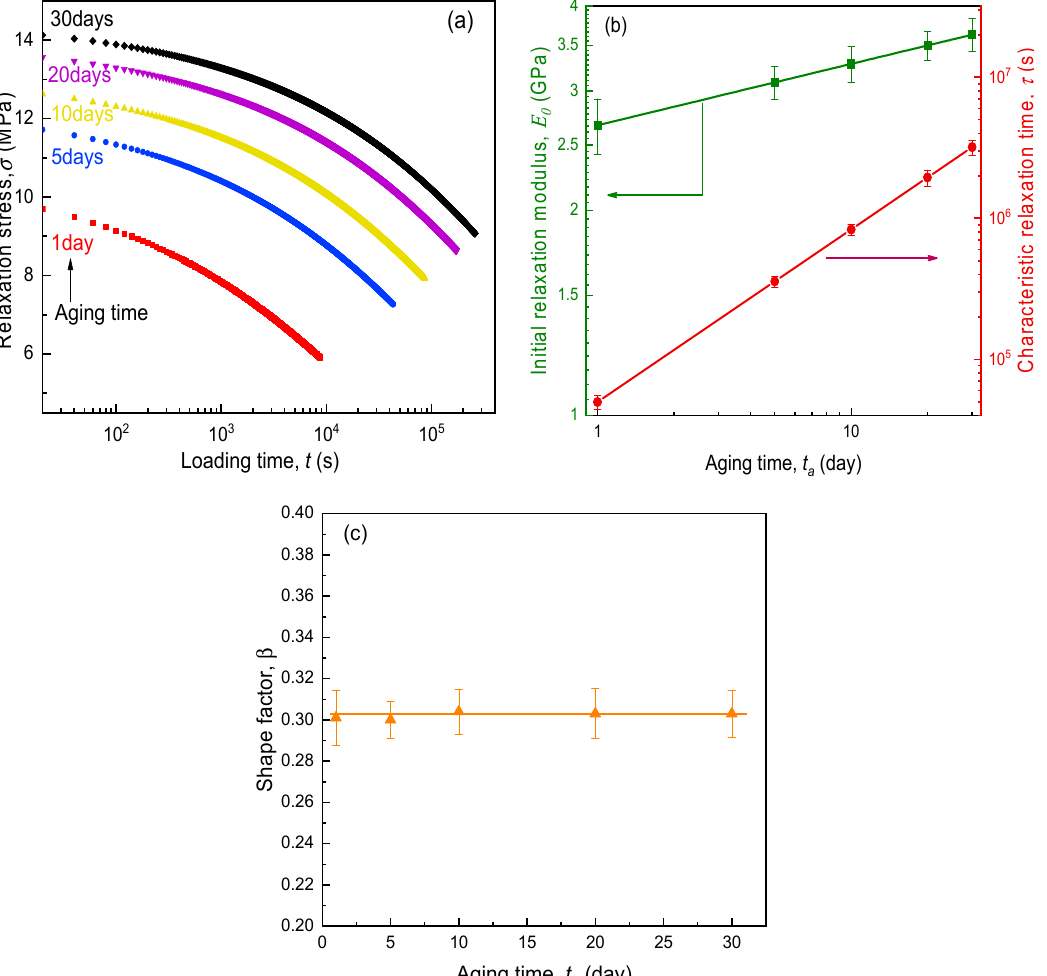
Figure 5. Effect of physical aging on ( a ) stress relaxation curves and Kohlrausch–Williams–Watts (KWW) parameters: ( b ) E 0 and τ , ( c ) β